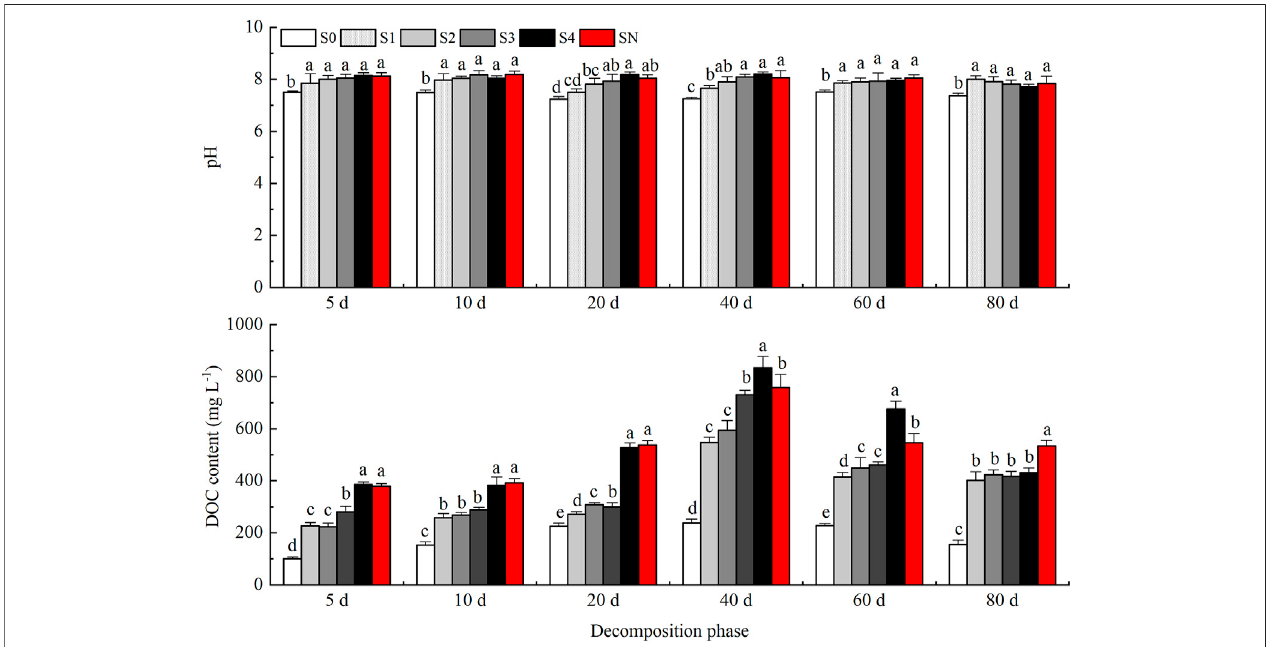
FIGURE 1 | pH and DOC content in soil leachate in response to wheat straw addition. The vertical bars denote standard errors. Columns with different letters represent signi fi cant difference ( p < 0.05).